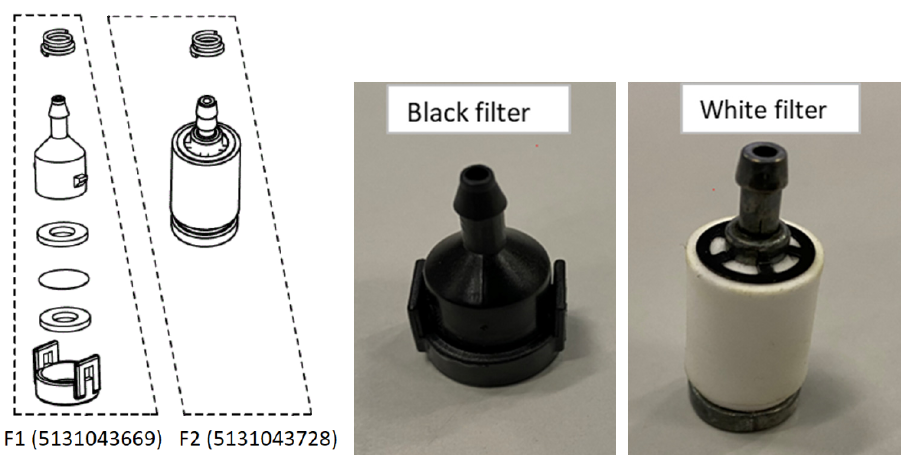
Figure 3. Applied filters: F1 (black filter) and F2 (white filter) and their construction.